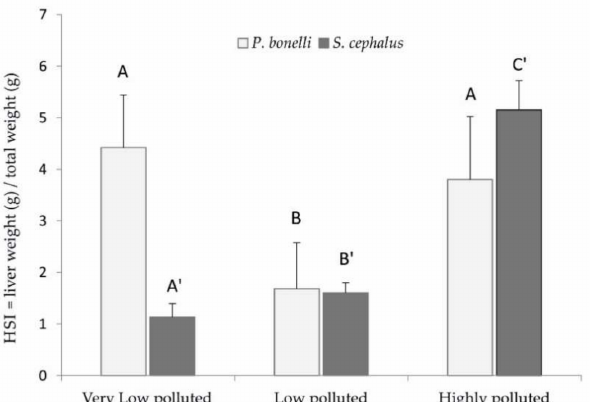
Figure 4. Hepatosomatic index in P. bonelli and S. cephalus . Values (grams of liver weight per grams of total body weight) are indicated as mean ± SD. The three means were statistically compared with each other. Different letters correspond to significant statistical differences ( p < 0.05) among different sites (Student–Newman–Keuls test). P. bonelli specimens: Site 1 n = 9, Sites 2 and 3 n = 10. S. cephalus specimens: Site 1 n = 8, Site 2 n = 9, and Site 3 n = 6.